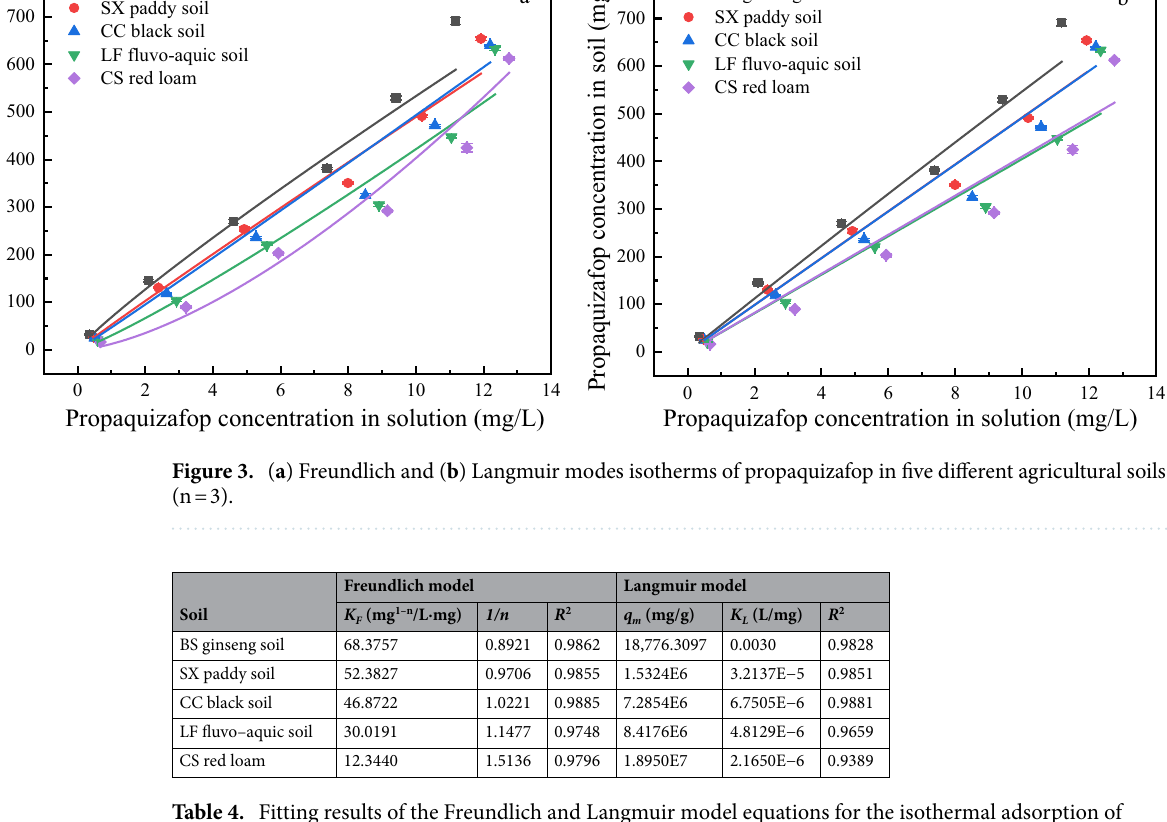
Table 4. Fitting results of the Freundlich and Langmuir model equations for the isothermal adsorption of propaquizafop in five different agricultural